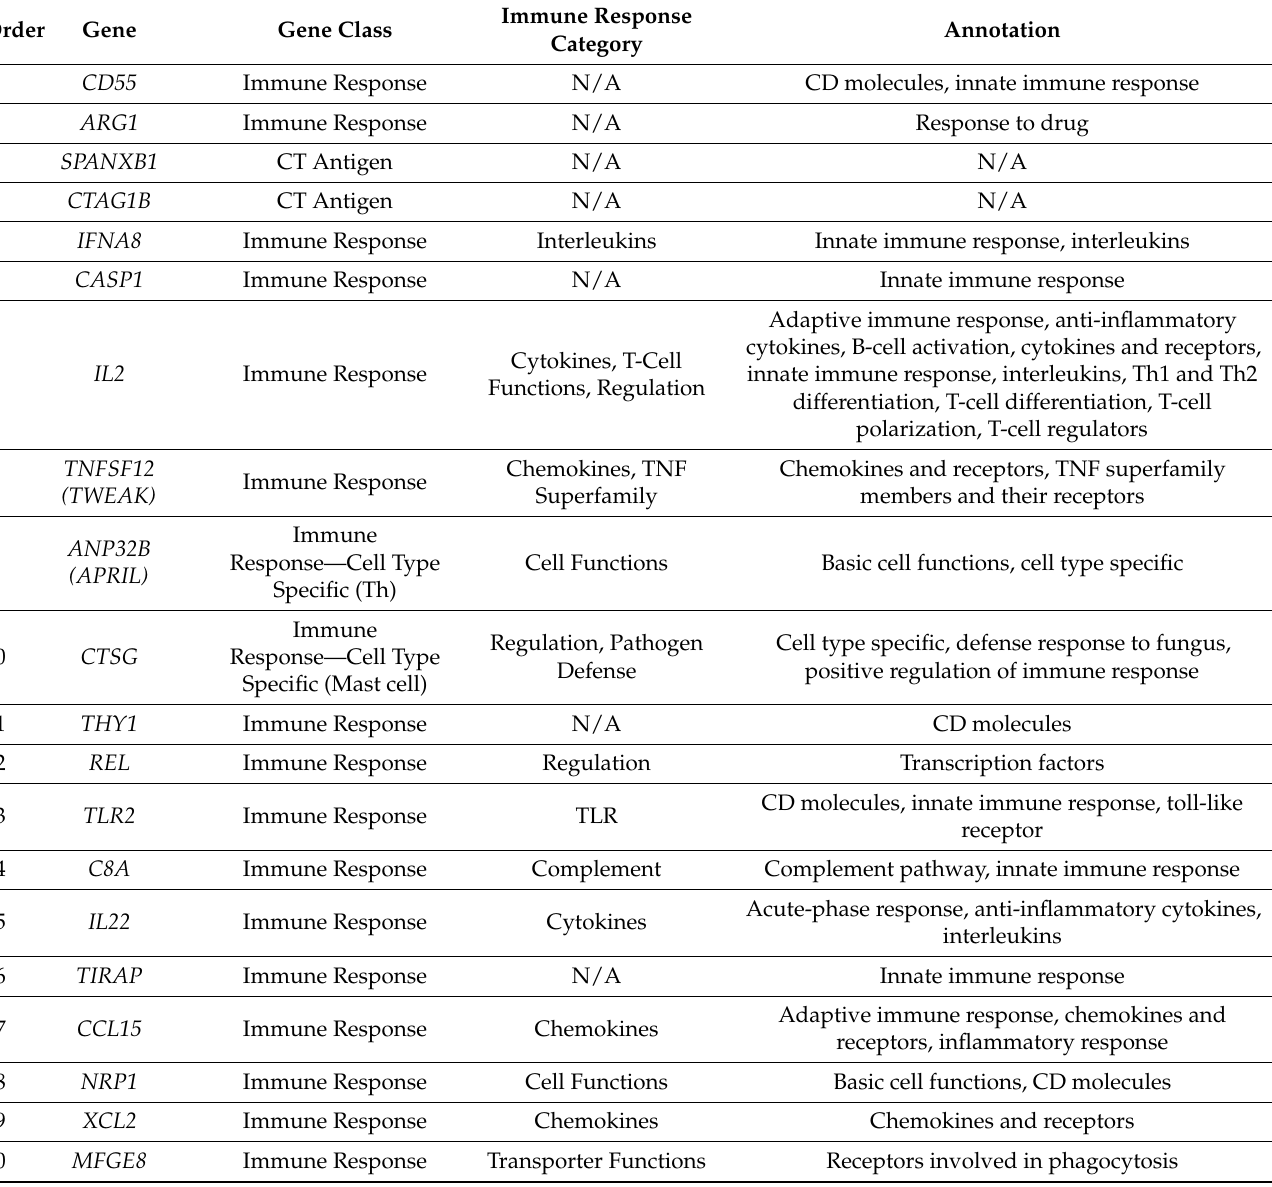
Table A3. Annotations of the overall survival top